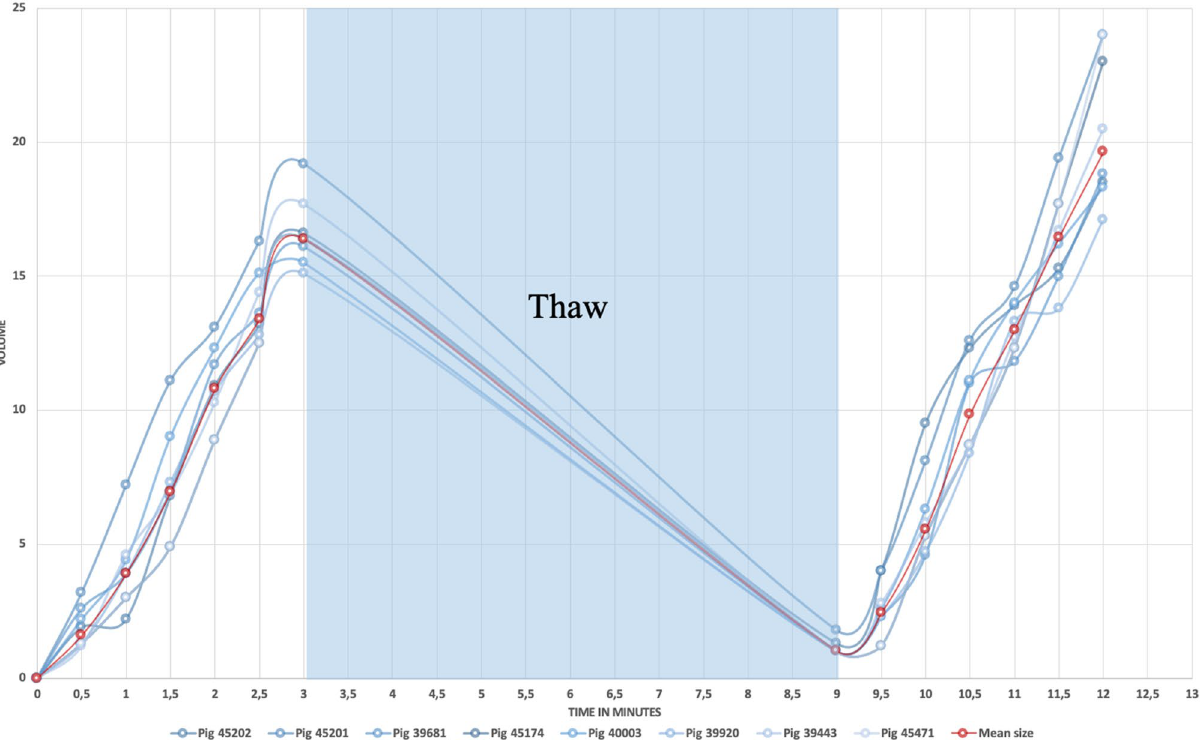
Figure 2. Ice volume development in cm 3 as a function of time in minutes, shown for all 8 pigs. The red line represents mean values. The volume decrease in the thaw period is presumed as no CT scans were obtained in this phase.